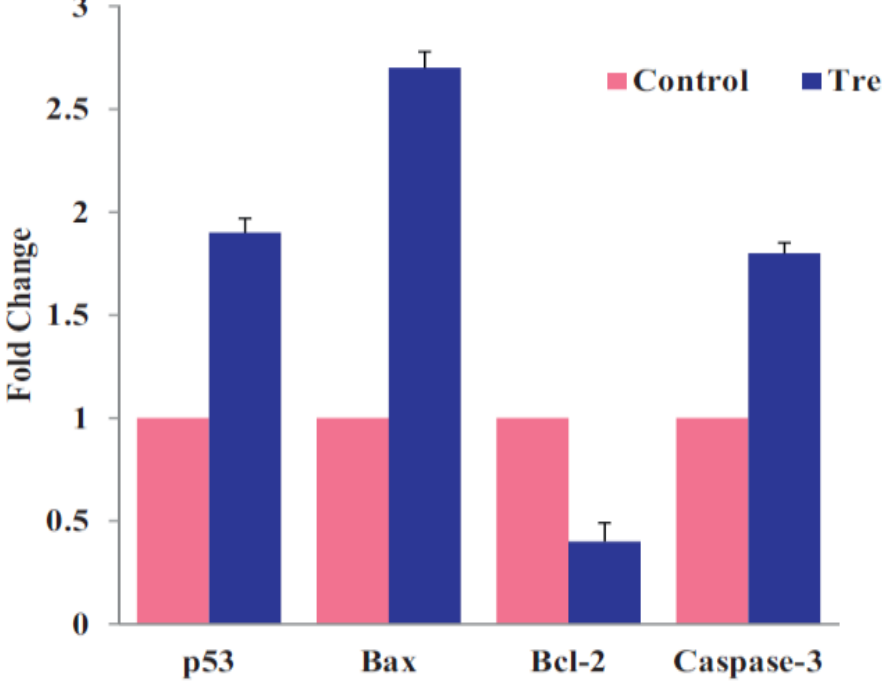
Figure 26. The mRNA expression levels of apoptotic markers in HepG2 cells treated with ZnO NPs at a dose of 50 µ g / mL for 24 h. The data are presented as mean ± standard deviation of three identical experiments with three replicates. Reproduced from [150] with permission of Elsevier.